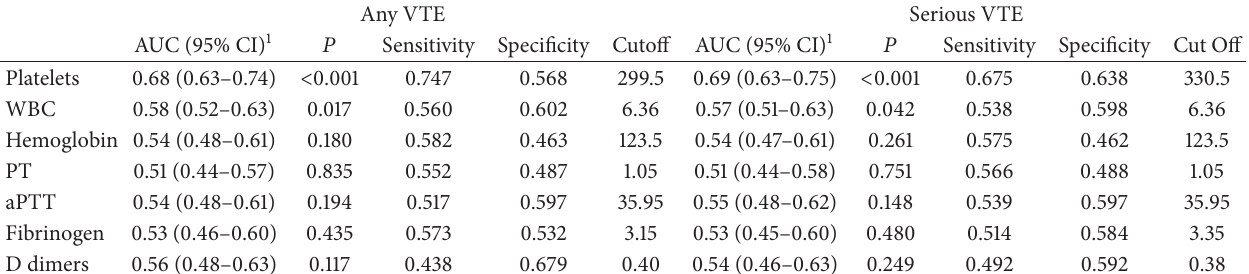
Table 4: Hemostatic factors “cut-offs” for venous thromboembolic events.